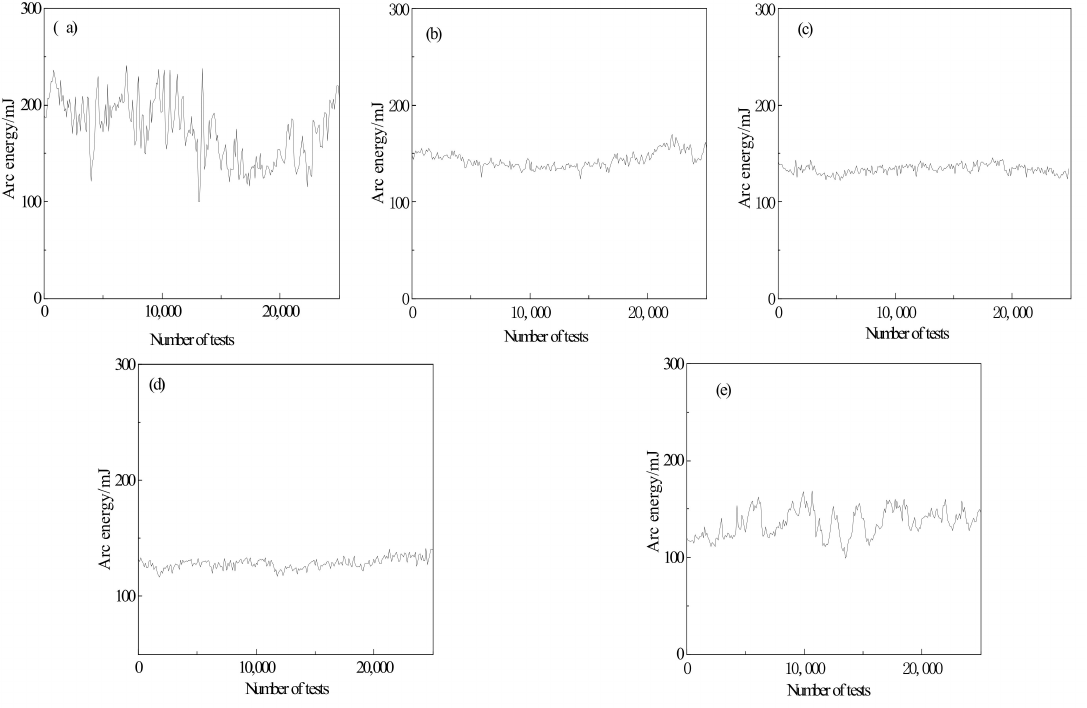
Figure 6. Arc energy of Sn 1 − x Cr x O 2 contact material. ( a ) x = 0; ( b ) x = 0.083; ( c ) x = 0.125; ( d ) x = 0.167; ( e ) x =